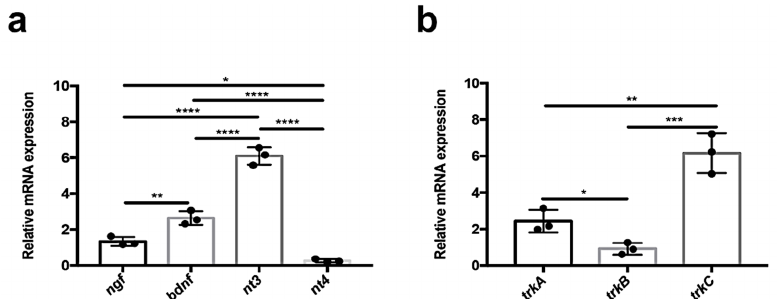
Figure 1. Analysis of neurotrophin and receptor expression by qPCR. ( a ) qPCR analysis for neu- rotrophic factors: ngf ; bdnf ; nt3 ; nt4 . ngf is more expressed than nt4 (not significatively expressed),